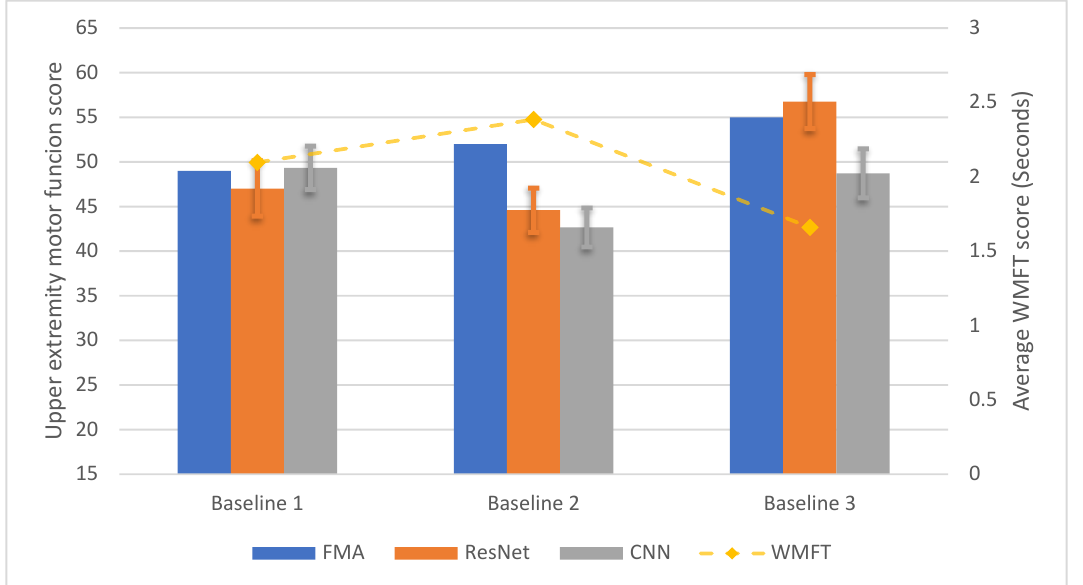
Figure 6. The longitudinal test results of the ANN models with EEG data collected from P2.